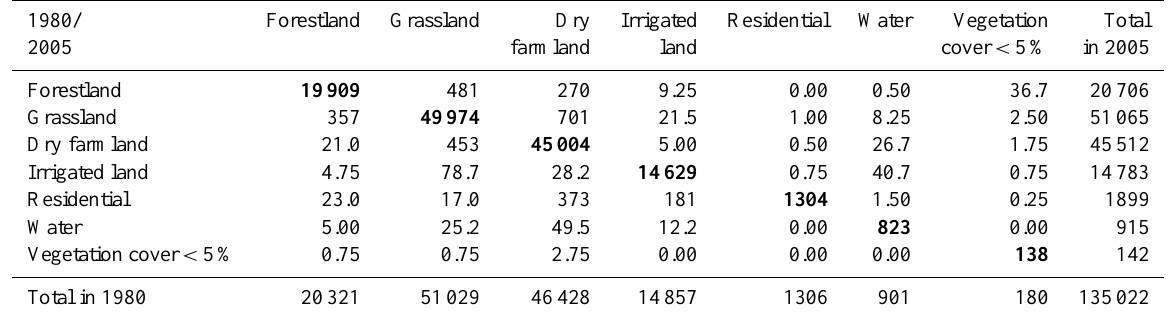
Table 2. The transition matrix of land use change and total area of different land use in 2005 and 1980 in the Wei River basin (land use in km 2 ).